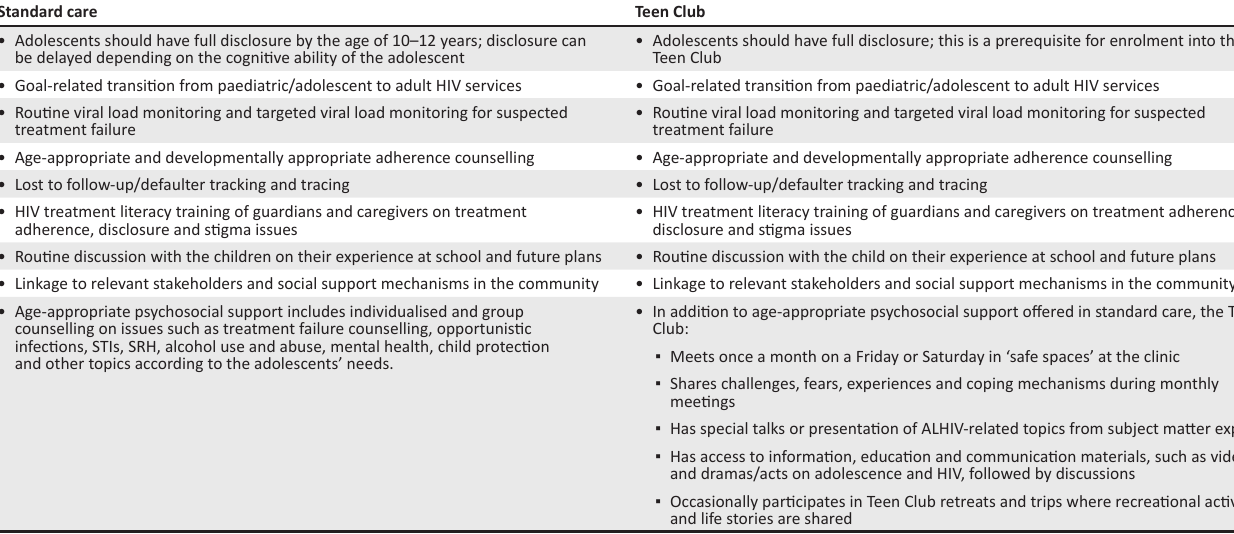
TABLE 1: Comparison of standard care and Teen Club care. Standard care